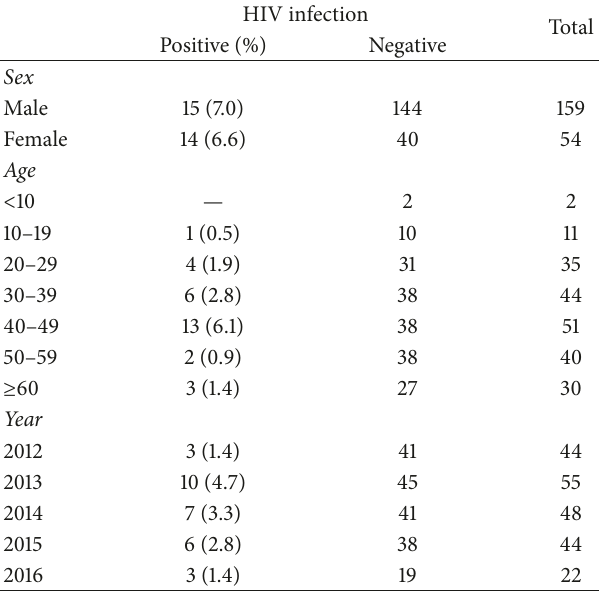
Table 4: HIV infection status among TB clients.